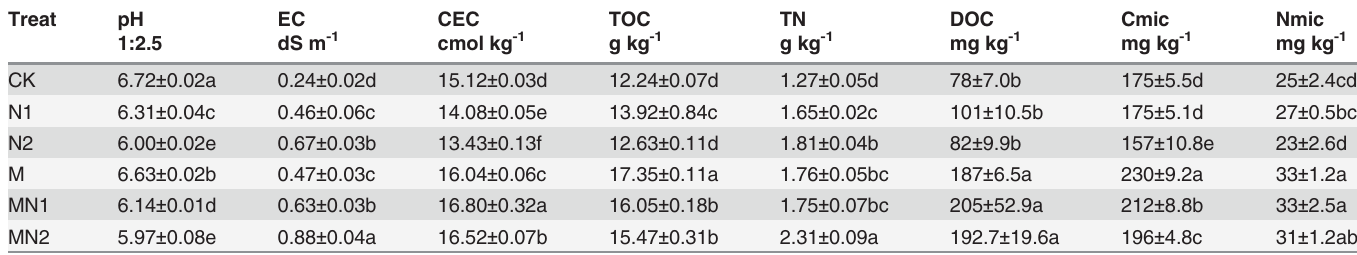
Table 1. Response of soil properties to the long-term effects of manure and different levels of N fertilizers under greenhouse condition (means ± S.D.). Treat pH